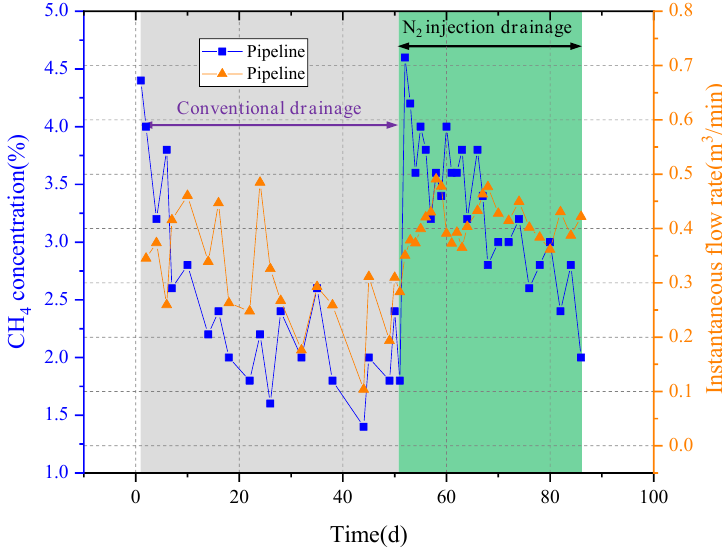
Figure 10. Drainage parameters of pipeline with respect to time.